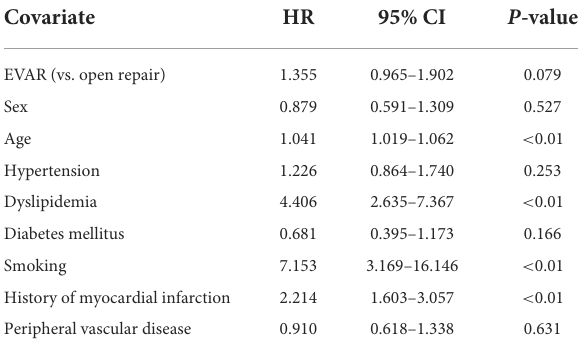
TABLE 7 Hazard ratios (HRs) and proportional hazards model (multivariate model) results for the overall survival rate of AAA surgery.